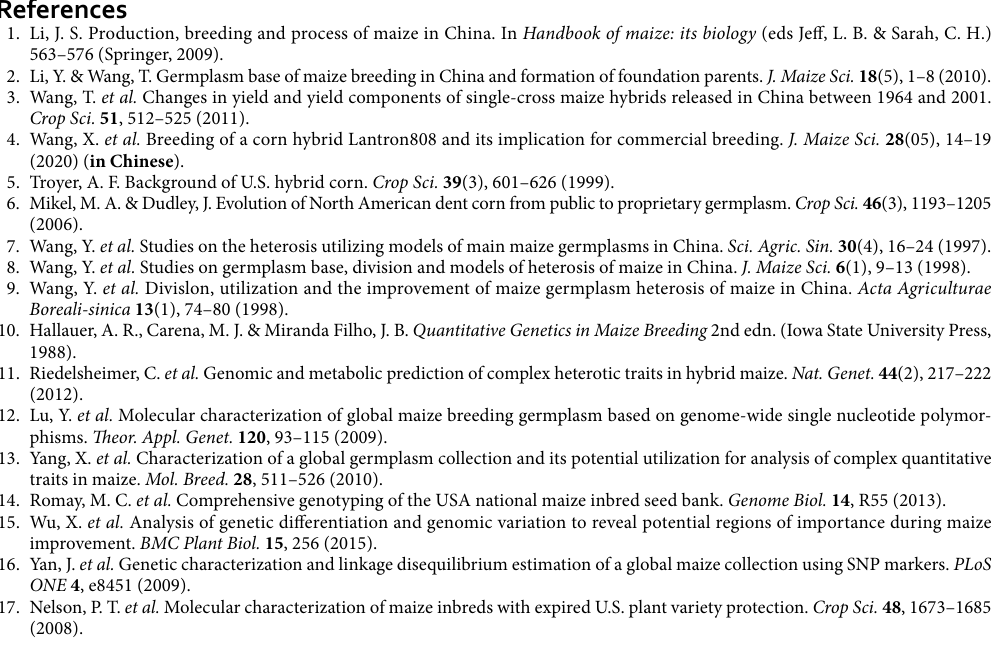
(took up to 30% of corn planting area at its peak years of 2000s) leads to the increasing use of M-Reid_Z58 and TSPT_C72 breeding germplasm which are mostly derived from two inbred parents of Zhengdan 958: Zheng58 (Z58 for short) and Chang 7-2 (C72 for short) in inbred breeding programs in CSM region. Subgroups M-Reid_Z58 and TSPT_C72 count about 6% and 9% respectively in CSM breeding germplasm. The Type II, that is, X subgroup × Local subgroups, is exemplified by corn hybrid DH605 (DH351 × DH382, Nonghua 101 (NH60 × S121), Jingke 968 (Jing724 × Jing 92), and Liangyu 99 (Mo3 × M5972), many of them also have large presence in China Spring maize region. In the past two decades, corn hybrid grain yield per unit area has increased more than two folds in CSM region and corn germplasm basis and heterotic pattern at CSM region has changed significantly and North American germplasm become more important at CSM region. Wang et al. 7–9 have studied the CSM germplasm during later 1980s and early 1990s and has identified four major heterotic groups at CSM region and their rela- tive proportion: M-Reid (25.6%), Lancaster (25.6%), TSPT (16.2%), LRC (10.7%), counting about 78% of the CSM germplasm 7–9 , whereas the four groups M-Reid (15.1%), TSPT (15.1%), LRC + Lan (24%), count about 54% of total germplasm now (Fig. 8a), the 24% drop during the past two decages is due to the significant increase of four heterotic subgroups of North American origin: P(8%), SS (14%), IDT (8%), and X (6%) (Fig. 8b), counting about 32% of total germplasm in CSM region.